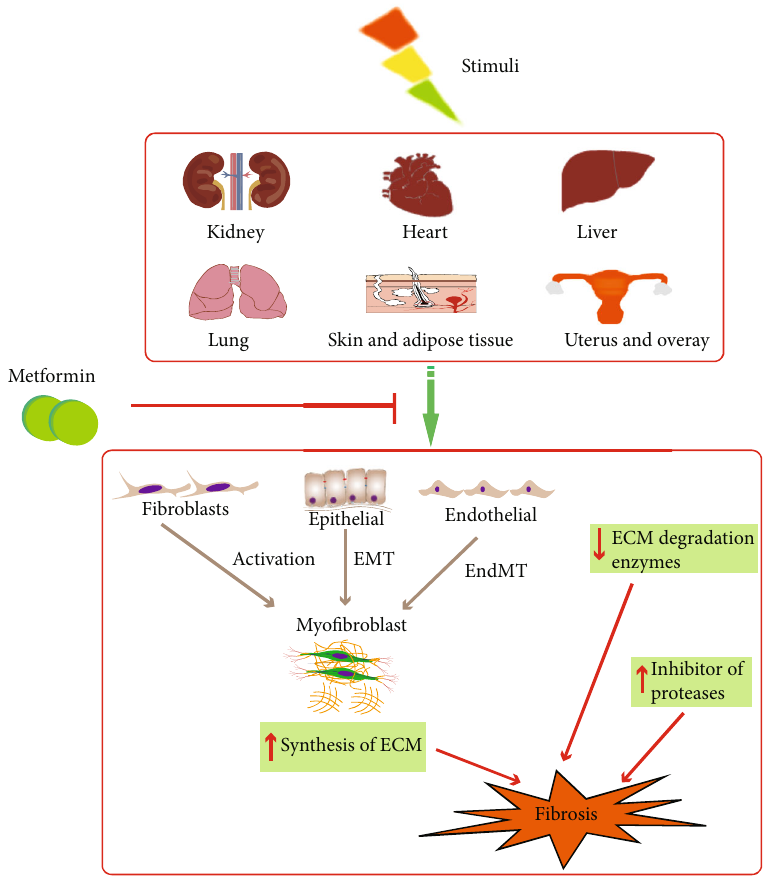
Figure 1: Metformin and organ fi